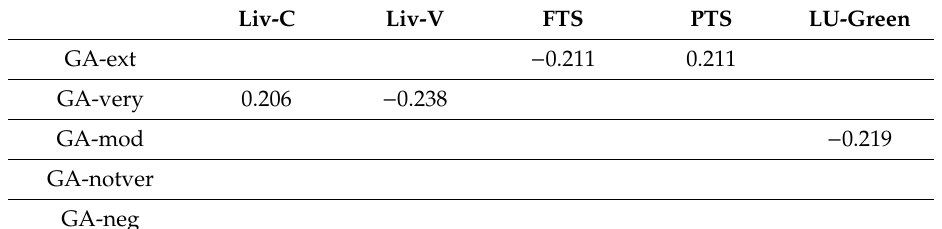
Figure 5. Opinion of the respondents on the perception of greenery by city inhabitants (EnvEng and CivEng students combined). Table 6. Comparison of highly significant correlations ( p > 0.01) between the individual perception of greenery by city inhabitants and other characteristics (EnvEng and CivEng students combined, n = 244).